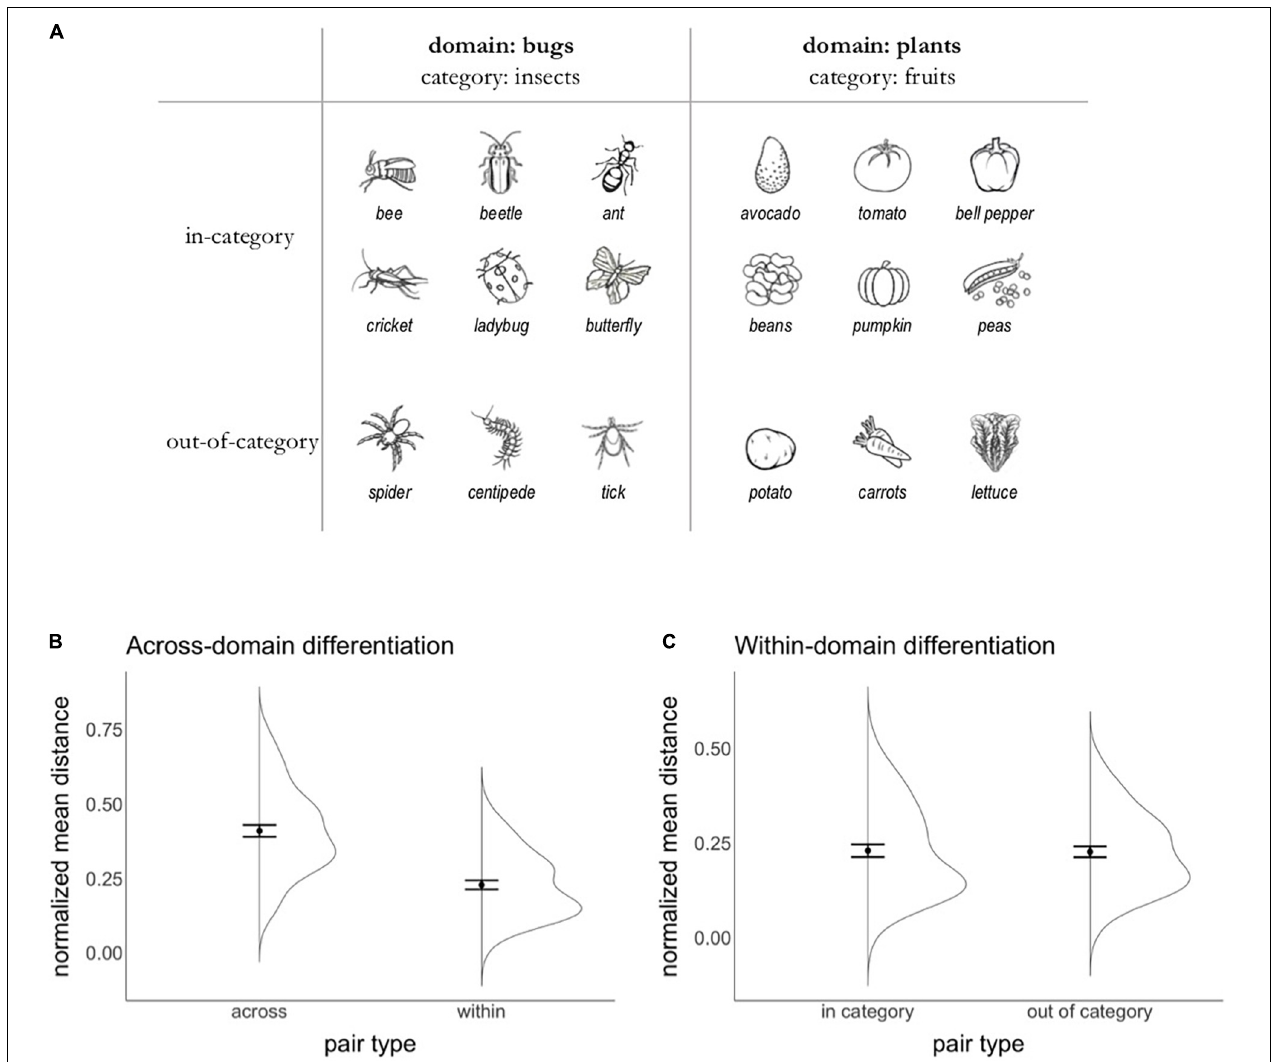
FIGURE 1 | Spatial arrangement task. (A) Stimuli used in the Spatial arrangement task. Children were asked to arrange 18 items, half of which belonged to the domain of ‘bugs’ and the other half to the domain of ‘plants.’ To test within-domain differentiation, in-category items (i.e., insect ‘bugs’ and ‘fruit’ plants) were contrasted with out-of-category items (i.e., non-insect ‘bugs’ and non-fruit ‘plants). (B) Mean distance (normalized by window size) at which pairs including two items of the same domain (within) and two items of different domains (across) were placed on the screen. Error bars represent standard errors of the mean. (C) Mean distance (normalized by window size) at which pairs including two items of the same category within a domain (in category) and two items of different categories within a domain (out of category) were placed on the screen. Error bars represent standard errors of the